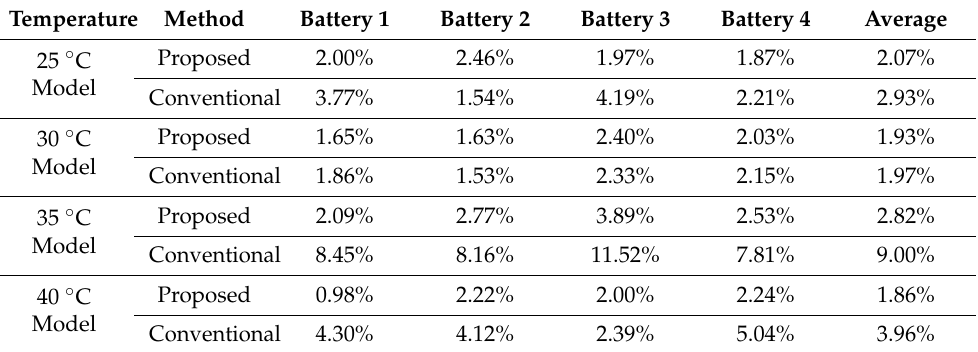
Table 6. The SOC errors obtained using the MNN model generated by the proposed and conventional methods.